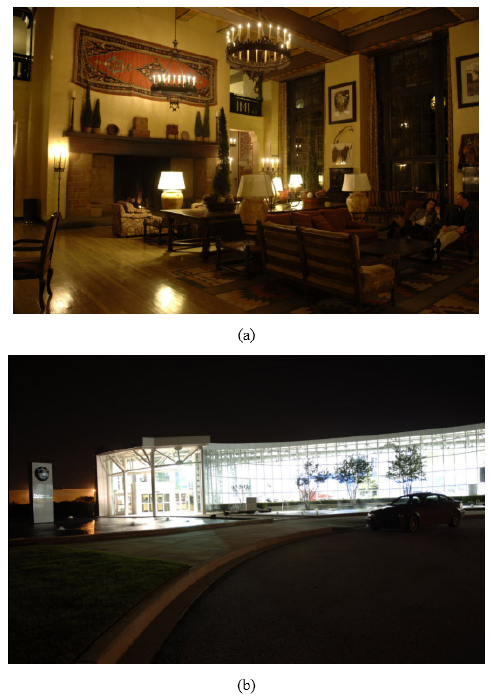
Figure 2: HDR Photographic Survey (a) Ahwahnee Great Lounge image with low luminance (b) Zentrum image with low lumi-